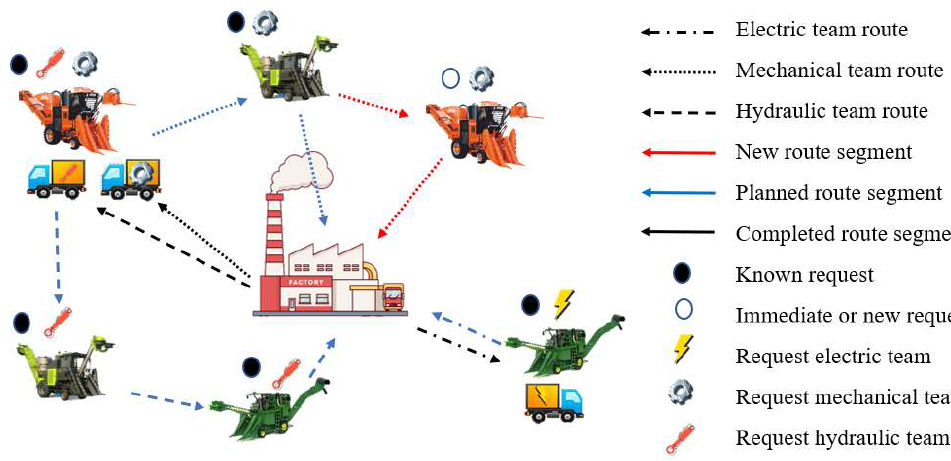
Figure 1. Systematic diagram of the multi-visit and multi-period dynamic workforce scheduling and routing problem (MMDWSRP).